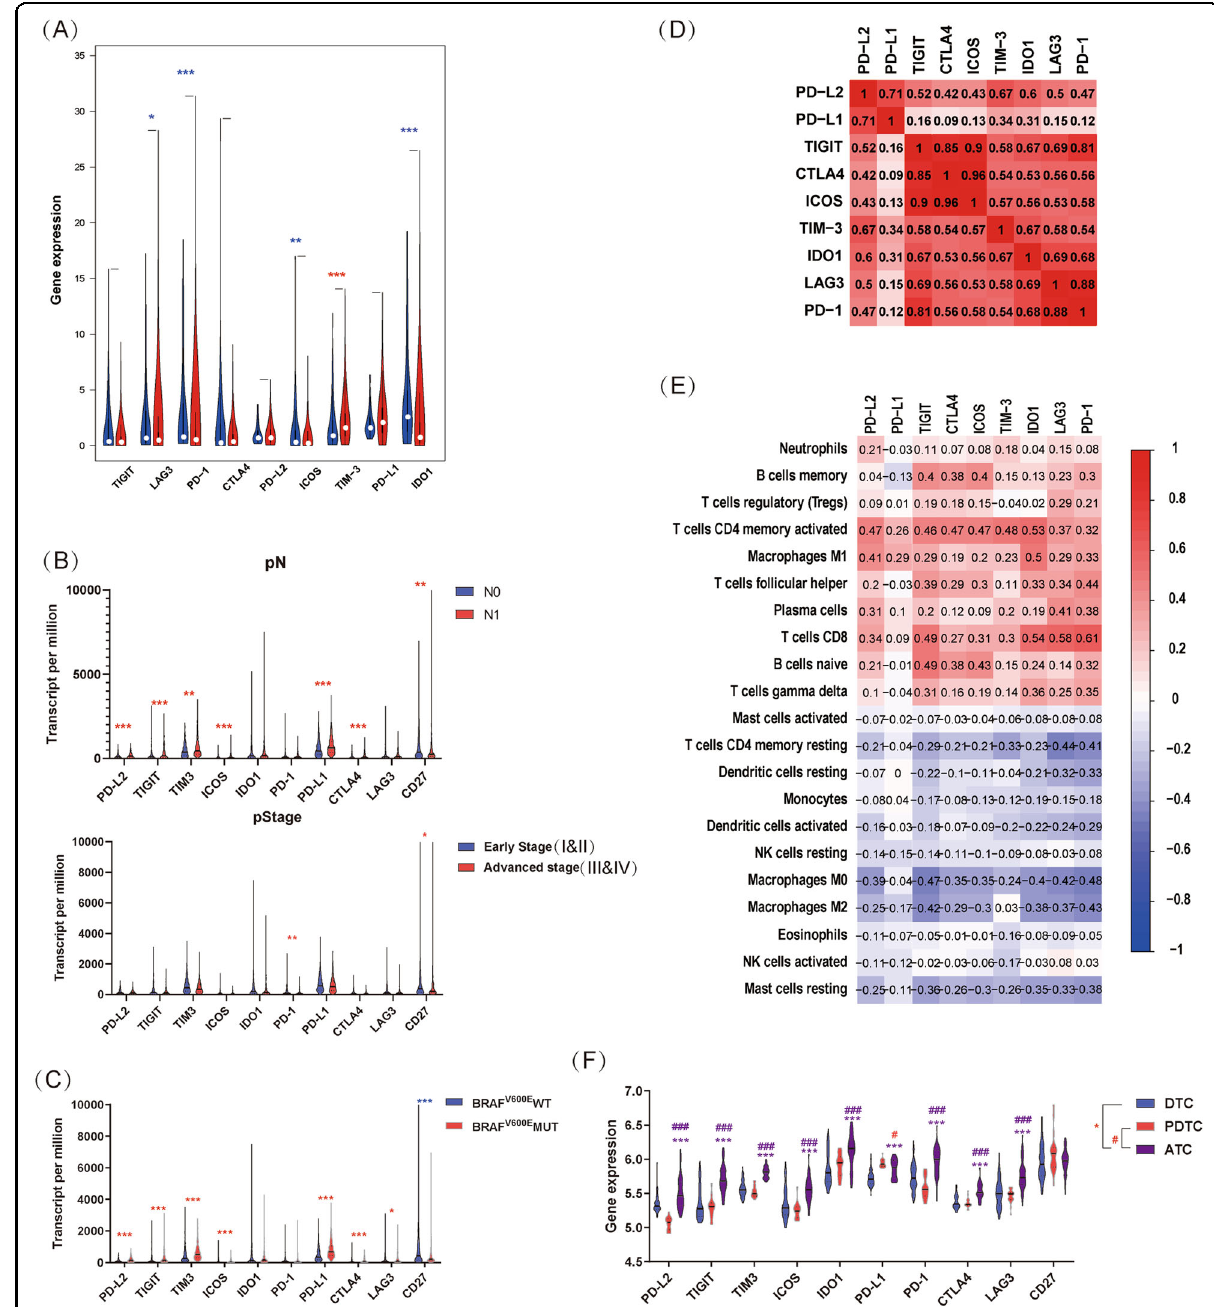
Fig. 4 Immune checkpoints in thyroid cancer. A Expression of various immune checkpoints in PTC and healthy thyroid tissues. B Correlation of immune checkpoints and pathological stage in PTC. C Correlation of immune checkpoints and BRAF V600E mutation in PTC. D Correlation matrix of immune checkpoints in PTC. E Correlation matrix of immune checkpoints and immune cells in PTC. F Correlation of immune checkpoints and different pathological types of thyroid cancer. (* P < 0.05, ** P < 0.01, *** P <